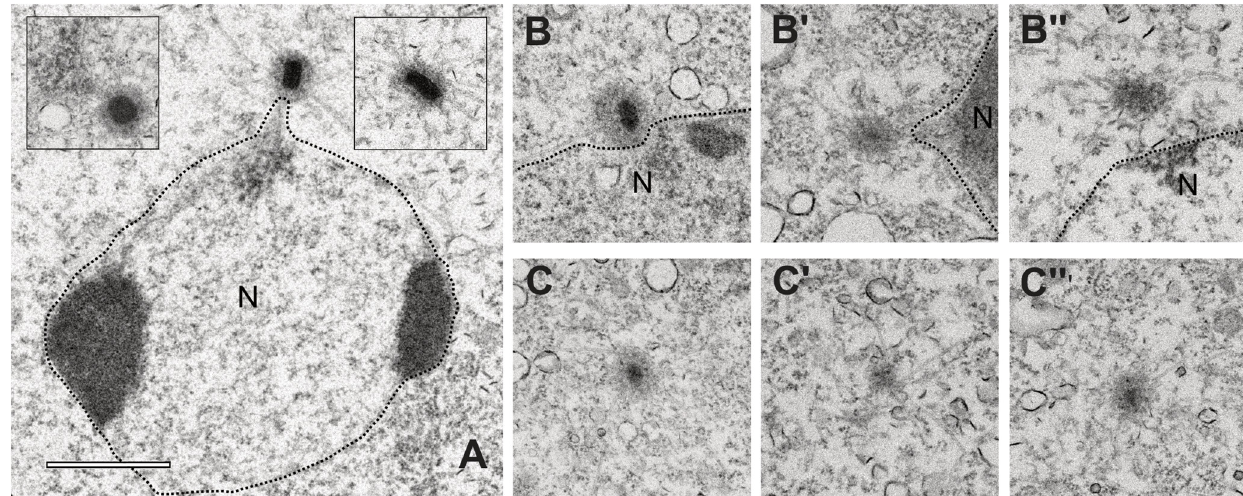
Figure 7. TEM images of centrosomes and MTOC. Centrosomes of AX2 control cells ( A , with insets) and Cep192-RNAi centrosomes ( B – B’’ ) and MTOCs ( C – C’’ ). The image of the control centrosome shows the attachment of the centrosome at the nucleus (N), the two insets show two different orientations of the core structure, with a view on top (left) and from the side (right). The cells were fixed with glutaraldehyde and after embedding sliced and imaged as 80–90 nm thick slices. Bar = 1 µm.